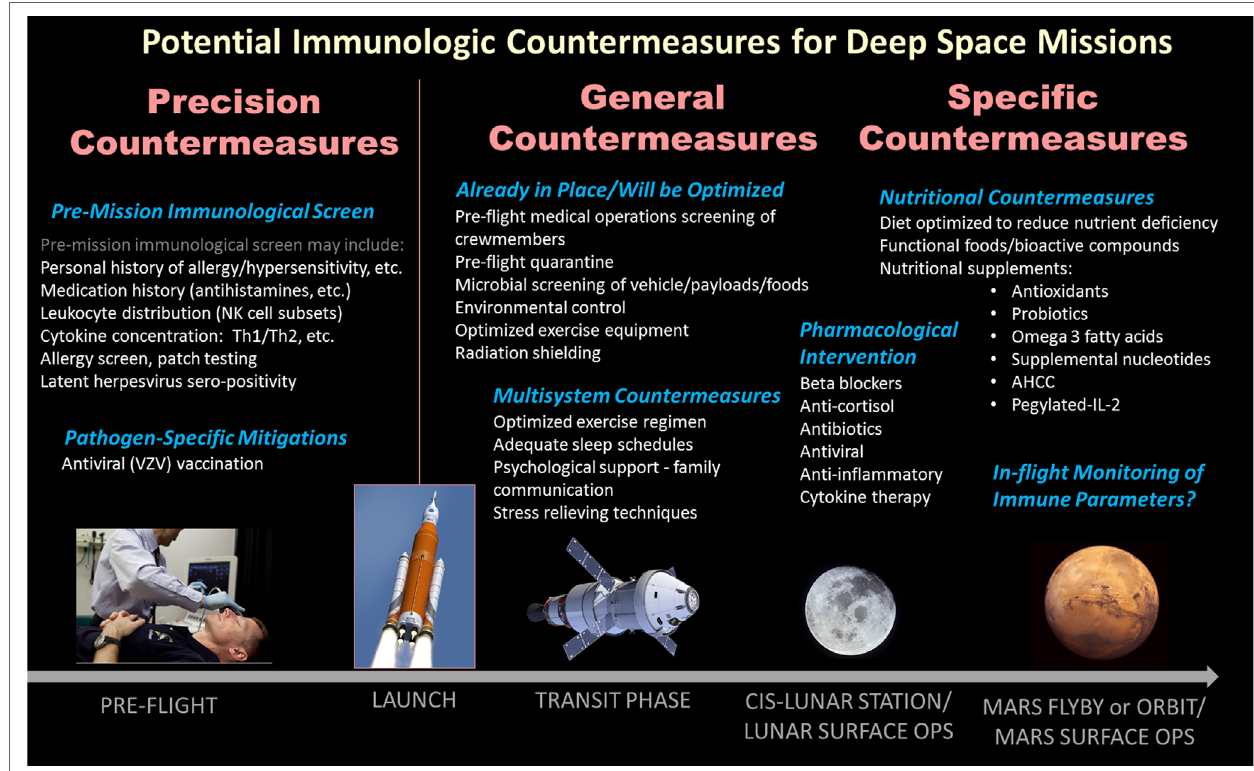
FiguRe 3 | Listing of likely biomedical and/or operational countermeasures for deep space exploration missions with the potential to benefit spaceflight-associated dysregulation of the human immune system. Broadly, the countermeasures may be considered general/operational multisystem influencing the entire crew, or specific biomedical treatments (generally ingestible). A third category, precision or personalized, describes the possibility to “screen” crewmembers pre-flight to determine their unique immunological biases or susceptibilities, against which specific in-flight countermeasures may be tailored for individual